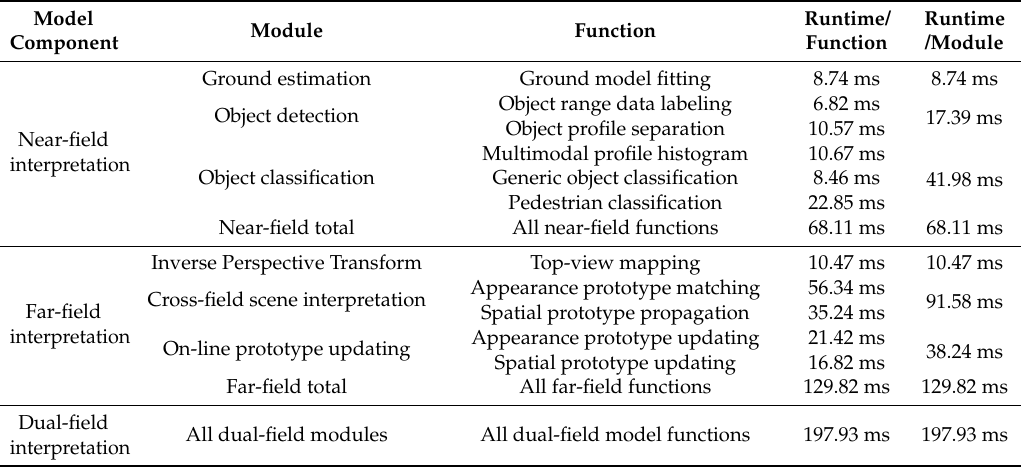
Table 6. Average run time performance of the dual-field sensing model.